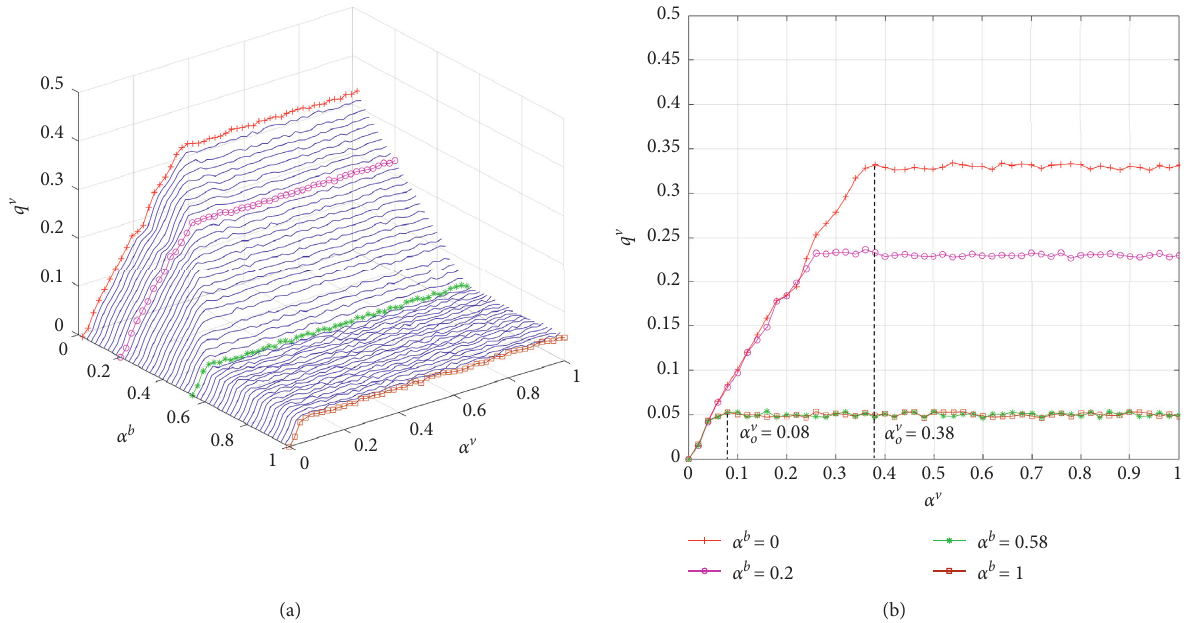
Figure 5: The relationship between the vehicle flow and the vehicle and bicycle inflow rate.